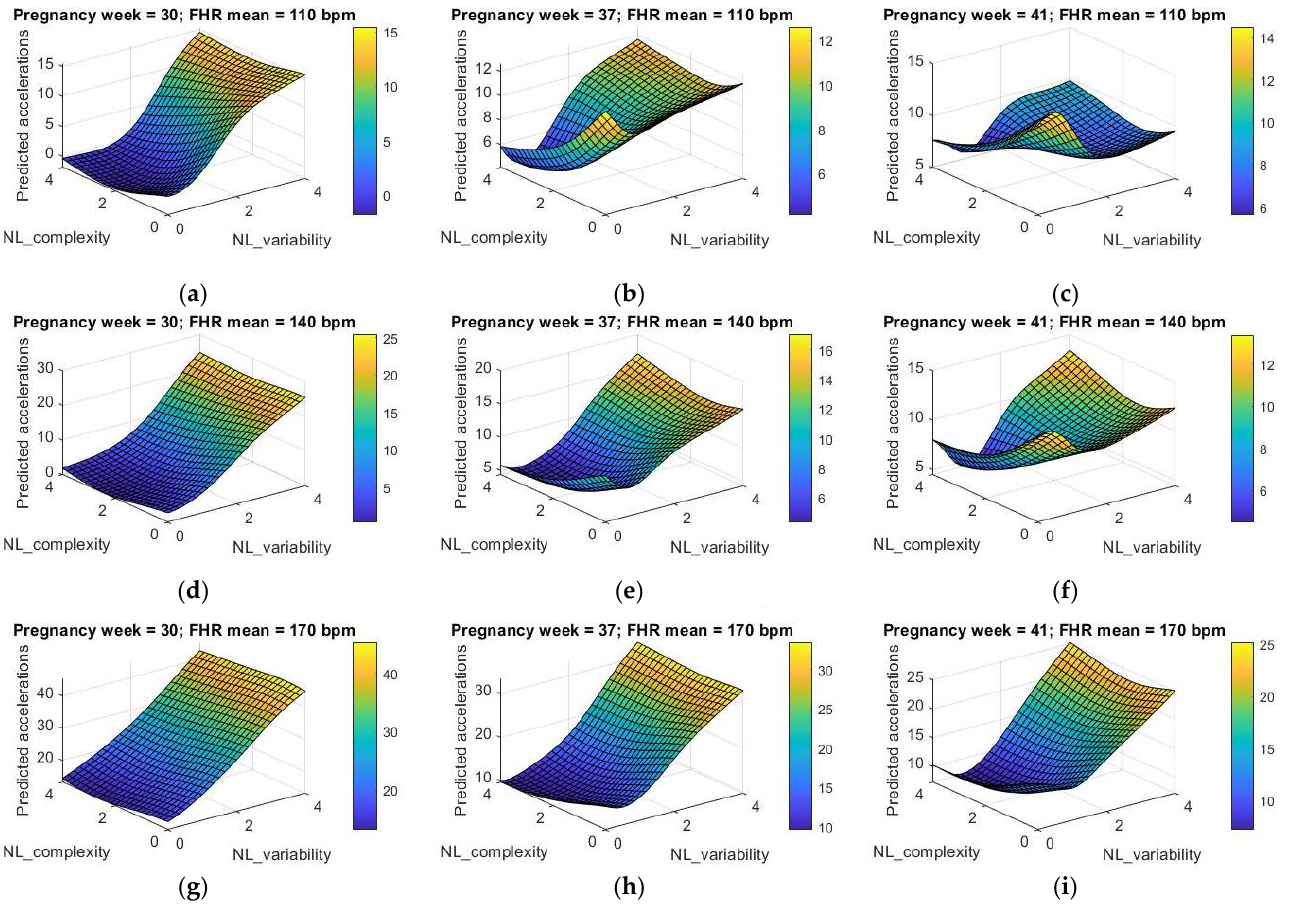
Figure 9. Effect of nonlinear features on the number of predicted FHR accelerations at three different pregnancy periods and three different values of the FHR mean: ( a ) 30th pregnancy week and FHR mean equal to 110 bpm; ( b ) 37th pregnancy week and FHR mean equal to 110 bpm; ( c ) 41st pregnancy week and FHR mean equal to 110 bpm; ( d ) 30th pregnancy week and FHR mean equal to 140 bpm; ( e ) 37th pregnancy week and FHR mean equal to 140 bpm; ( f ) 41st pregnancy week and FHR mean equal to 140 bpm; ( g ) 30th pregnancy week and FHR mean equal to 170 bpm; ( h ) 37th pregnancy week and FHR mean equal to 170 bpm; ( i ) 41st pregnancy week and FHR mean equal to 170 bpm.